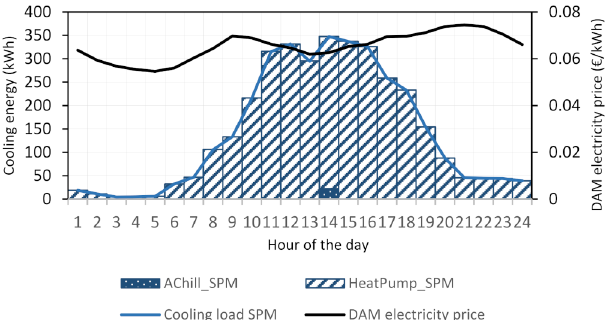
Figure 29. Cooling energy balance of the SPM obtained with environmental optimization for the representative summer